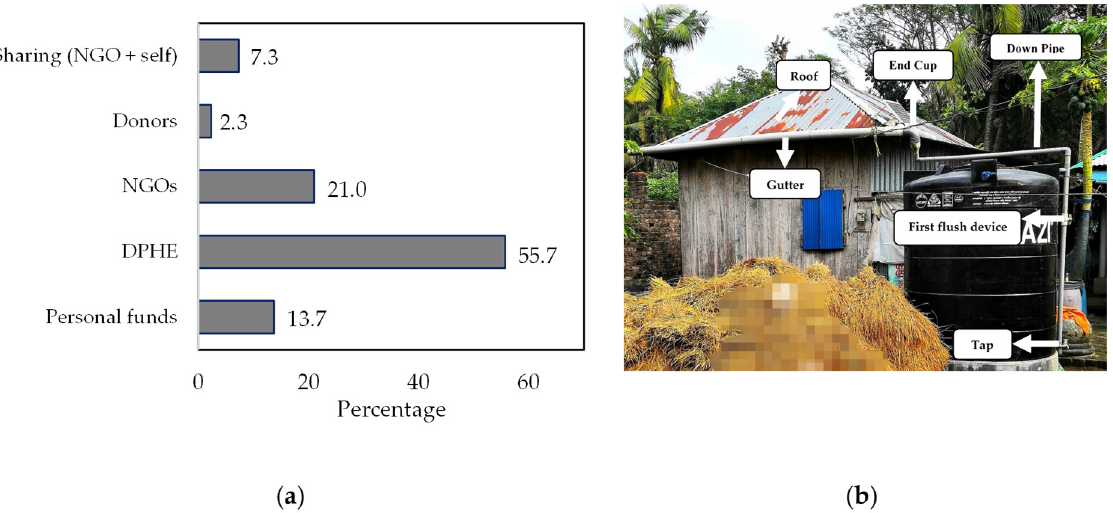
Figure 2. ( a ) Proportion of RWH systems installed by different means; ( b ) typical RWH system installed in the southwestern coastal region of Bangladesh, showing different components (Source: ITN-BUET).